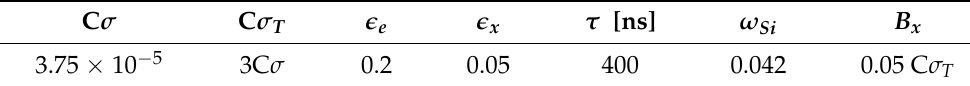
Table A1. The values for the parameters used in the calculation of comparison of SNR C and SNR EEL .